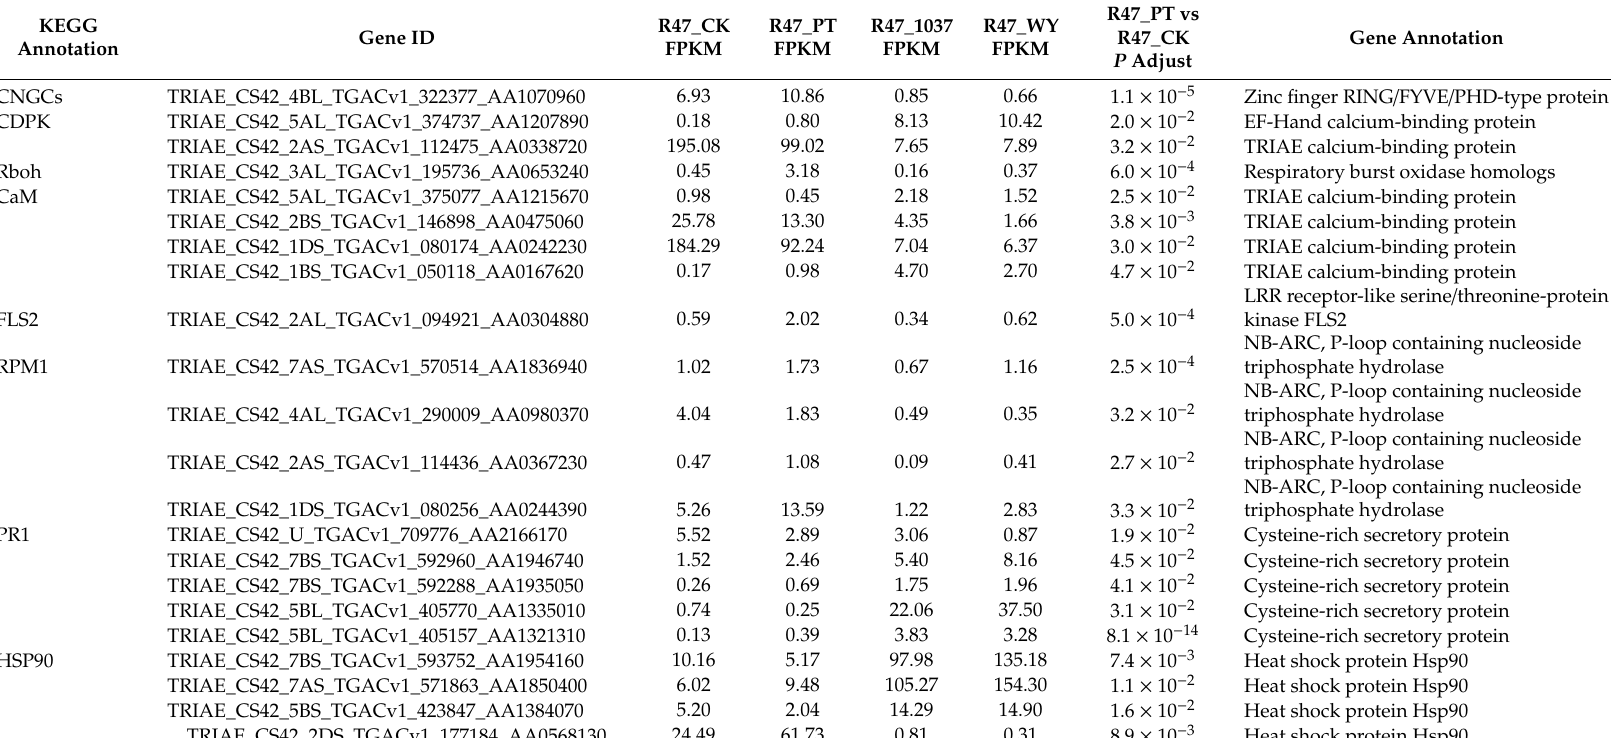
Table 1. DEGs annotated in the “plant–pathogen interaction” KEGG